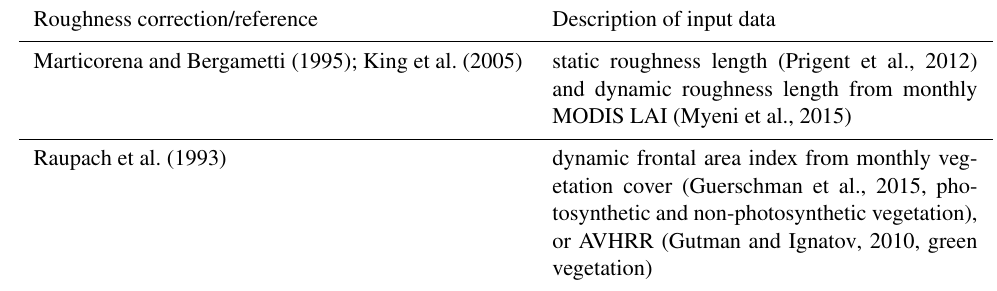
Table 5. Summary of available options in MONARCH to account for surface roughness in particle entrainment. Roughness